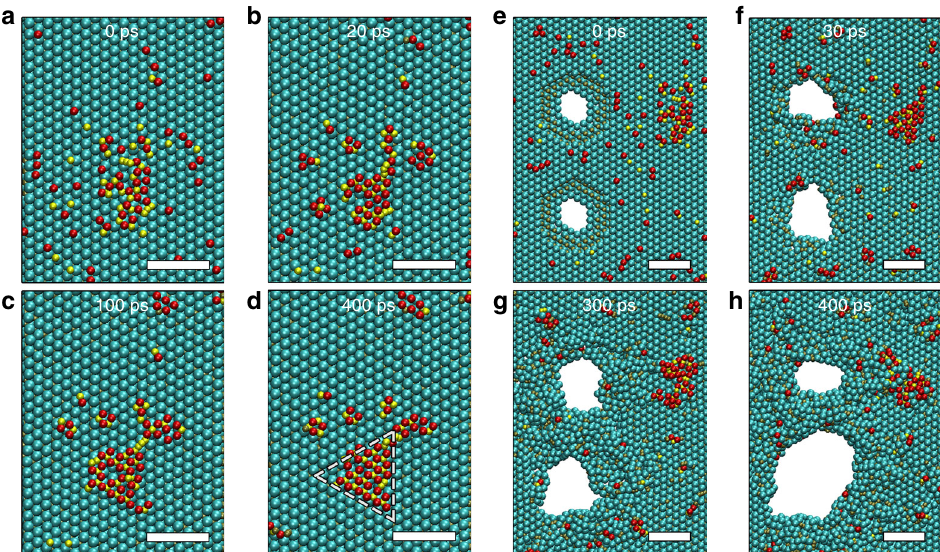
Fig. 5 ReaxFF Molecular dynamic simulation showing the structural evolution in MXene. a – d Island growth observed for an initial con fi guration with a Ti – C seed after different time periods of ReaxFF force-bias Monte Carlo/molecular dynamics (fbMC/MD) simulation at 1500 K. e – h Pore expansion observed for initial con fi guration with two pores and Ti – C seed after different time of fbMC/MD simulation at 2500 K. The scale bars are 1 nm. (adatom Ti: red, Ti: cyan, C: gold, adatom C: